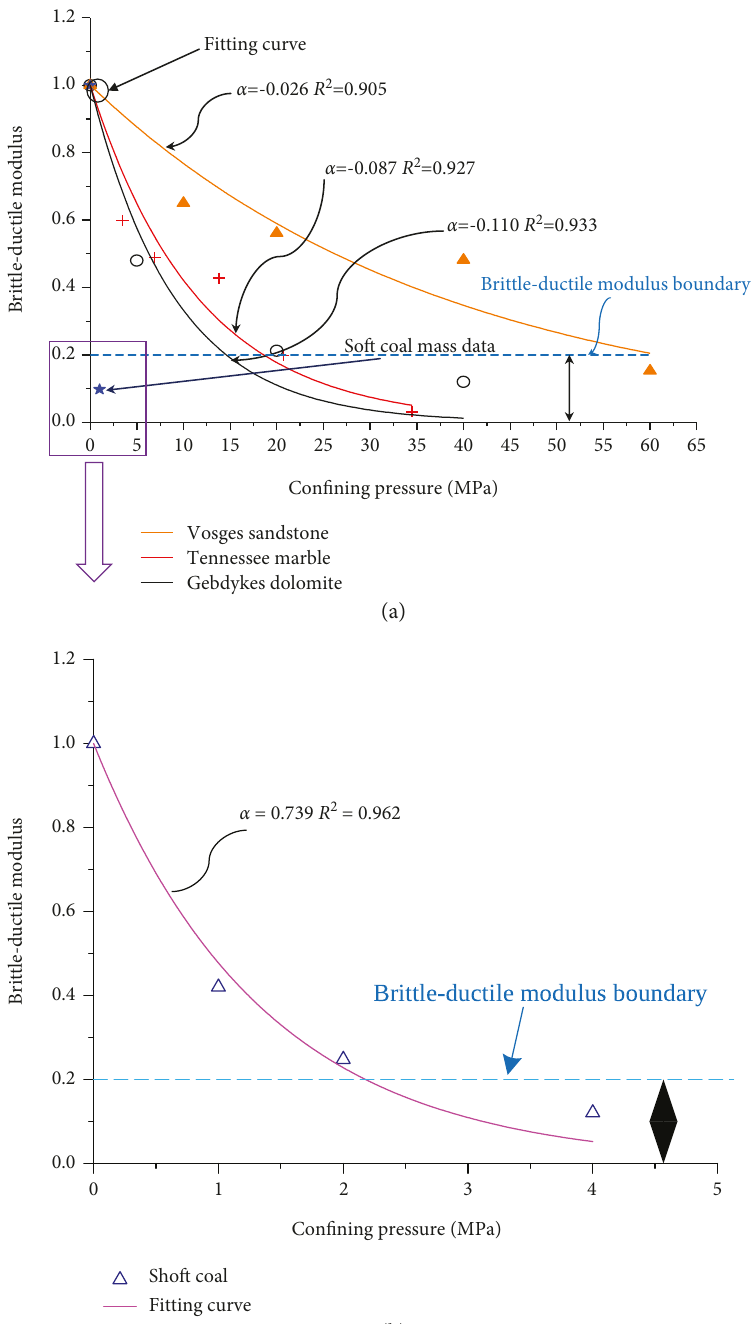
Figure 10: Therelationshipbetweencon fi